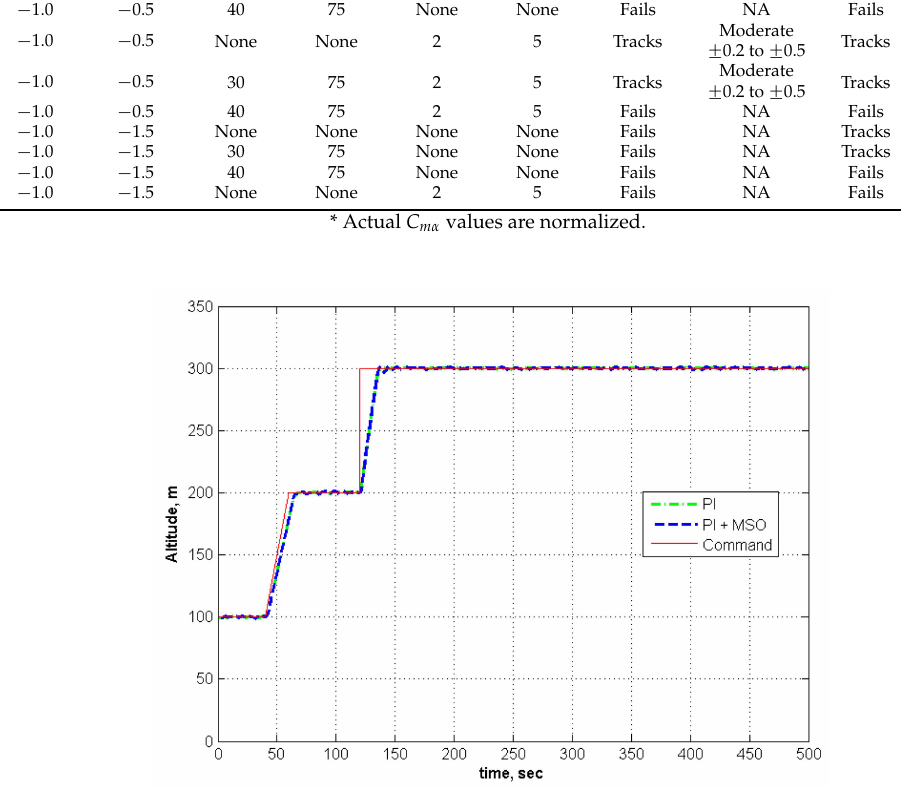
Figure 18. Altitude response for 50% C m α in the controller ( C m α in the controller = 0.5 ˆ design C m α ).